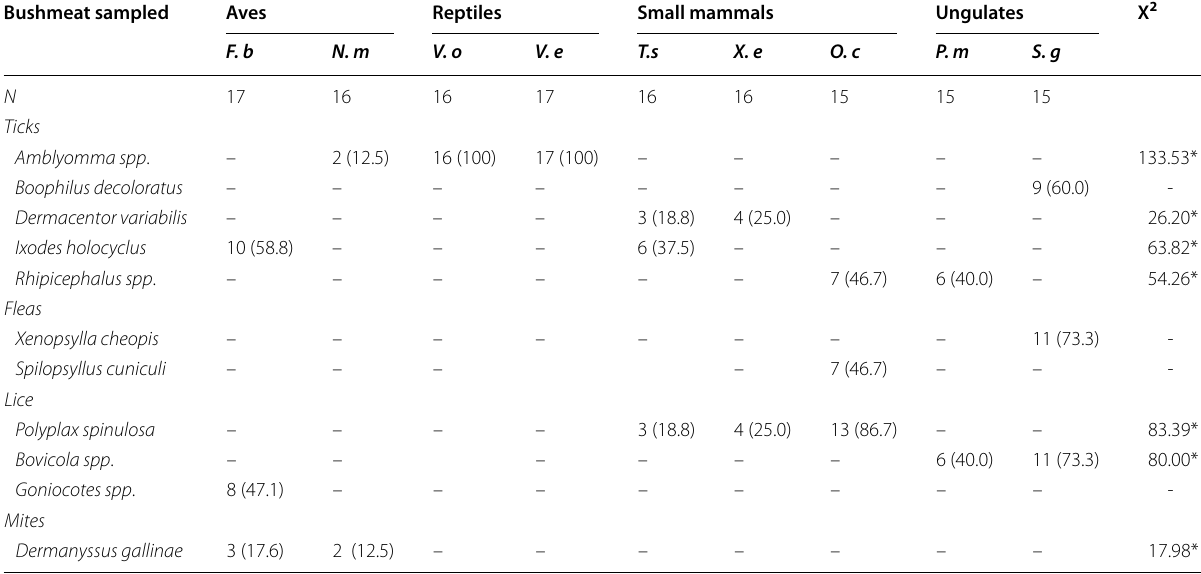
F. b F. Bicalcaratus , N.m = grimmia , N number of bushmeat sampled; values are presented as infected (%), X 2 =